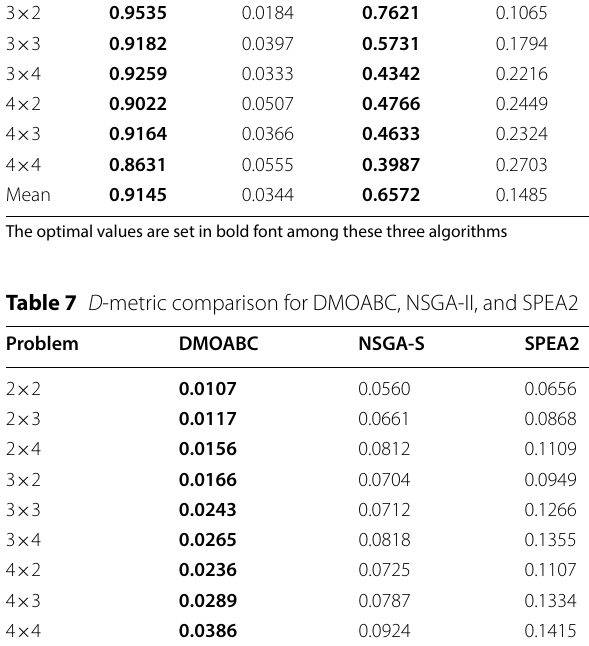
The optimal values are set in bold font among these three algorithms